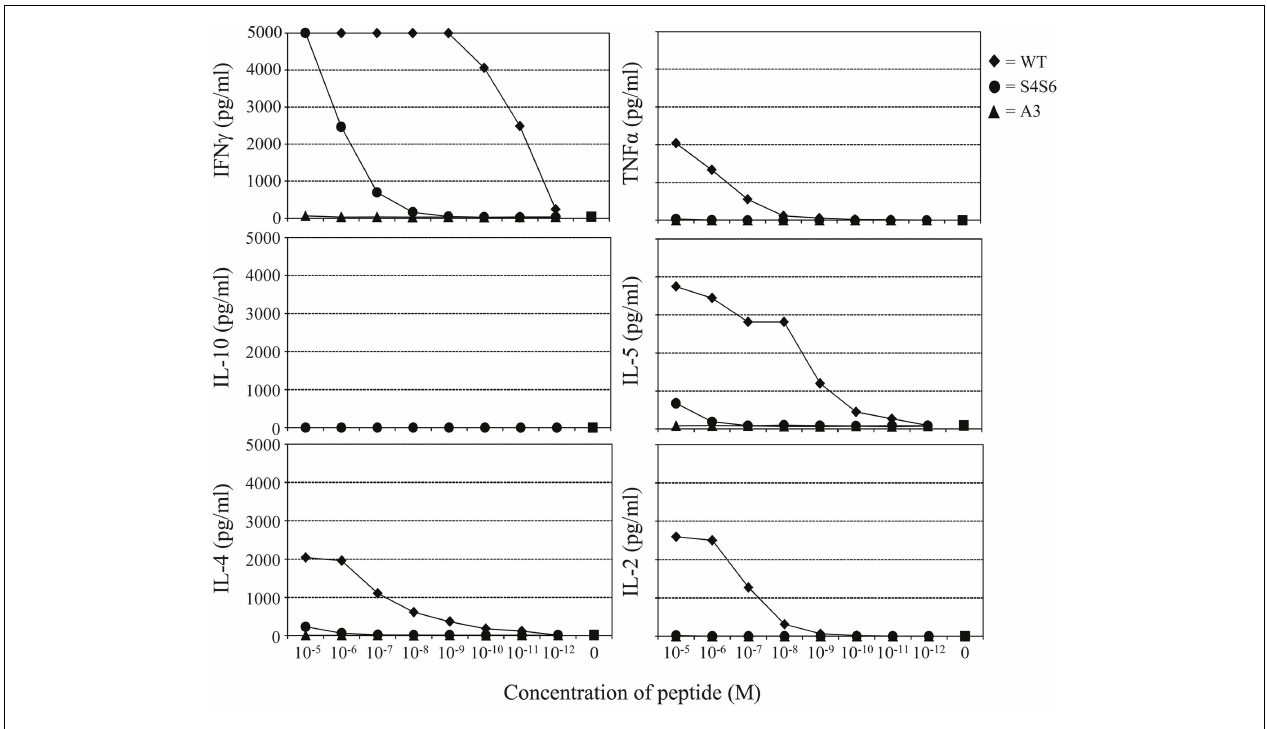
10 − 5 –10 − 12 M peptide). Following an 18h co-cultivation at an effector to target cell ratio of 3:1, supernatants were collected and measured for cytokine content. Results of one (out of three) representative experiment are shown based on the mean value of triplicate data